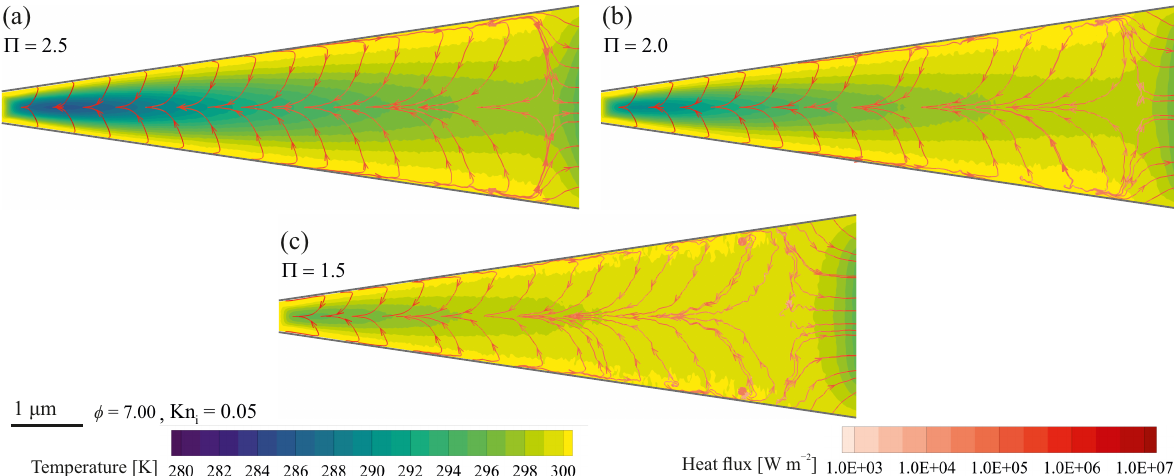
Figure 8. The effect of the inlet-to-outlet pressure ratio Π on the profiles of ( a ) gas temperature and ( b ) Mach number along the microchannel centreline ( φ = 7.00 and Kn = 0.05). The inlet temperature ( T i ) is used to non-dimensionalise the predicted temperatures.